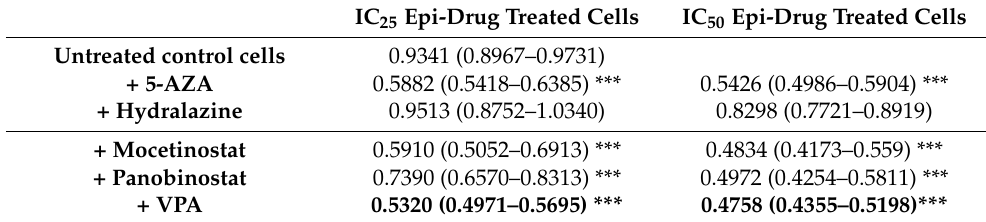
Table 1. IC 50 values of gemcitabine on cell growth in KPC3 cells with or without epi-drugs. IC 25 Epi-Drug Treated Cells IC 50 Epi-Drug Treated